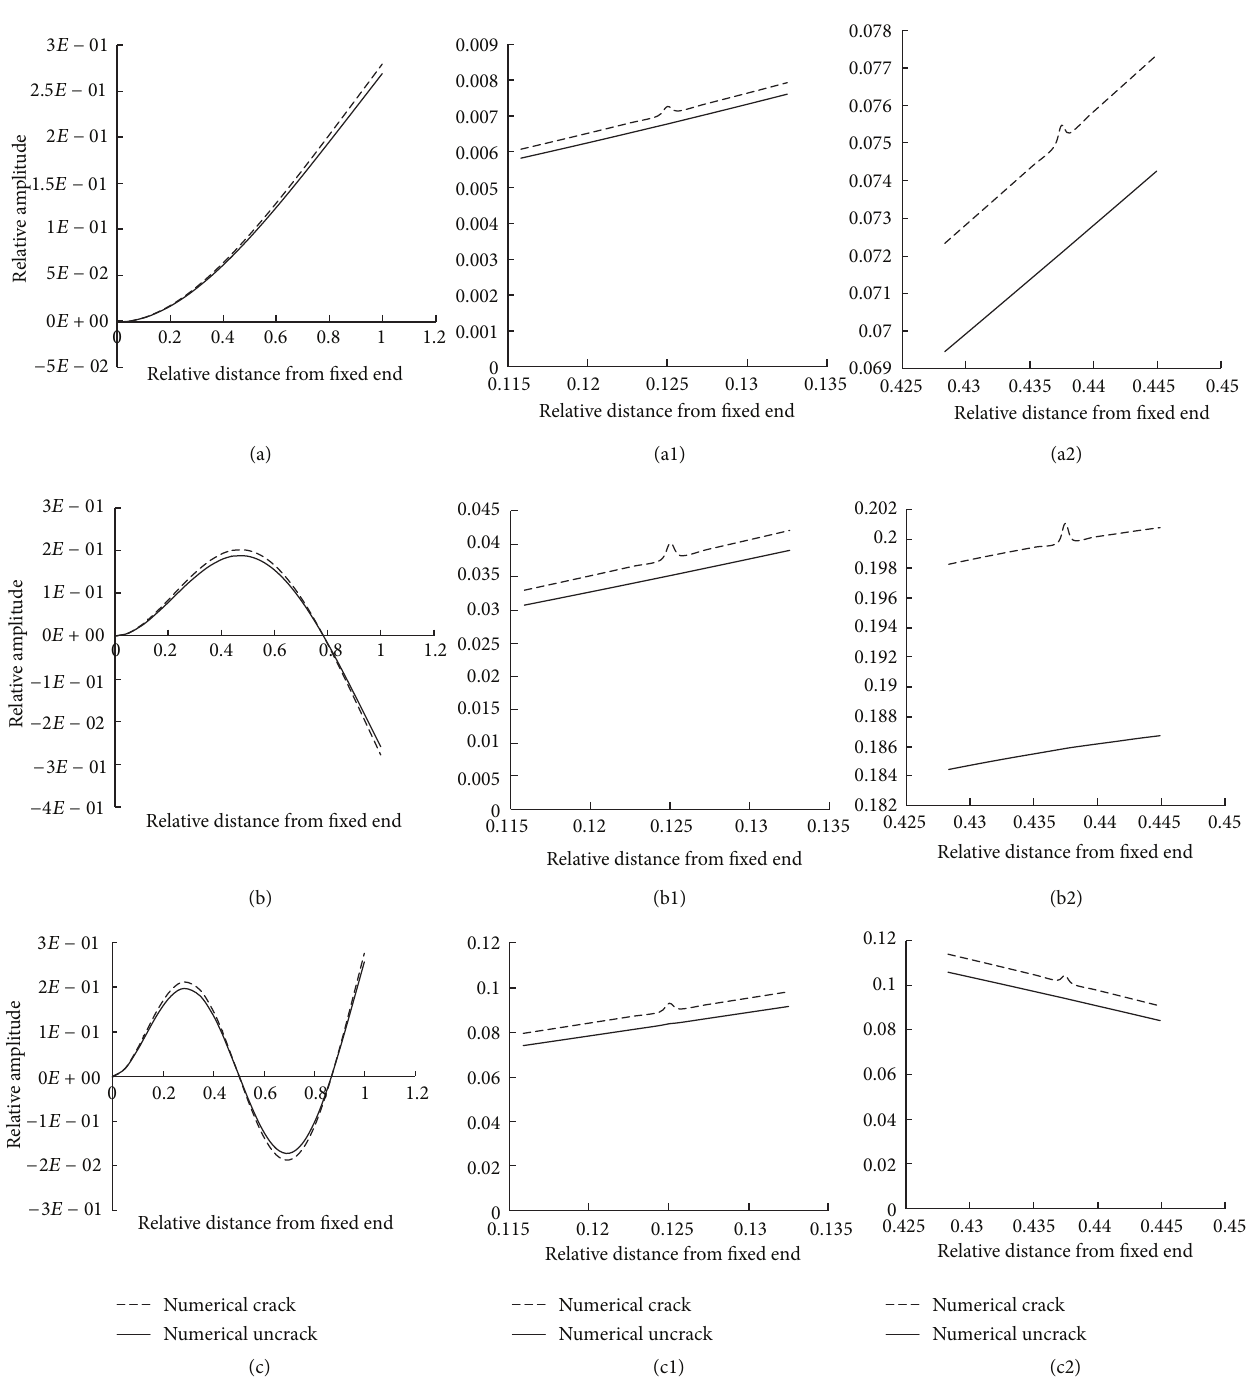
Figure 4: (a) Relative amplitude versus relative distance from the fixed end (1st mode of vibration), 𝑎 1 /𝑊 = 0.0833 , 𝑎 2 /𝑊 = 0.166 , 𝐿 1 /𝐿 = /𝐿 = 0.4375 . (a1) Magnified view of (a) at the vicinity of the crack location 𝐿 0.125 , 𝐿 2 the crack location 𝐿 2 /𝐿 = 0.4375 . (b) Relative amplitude versus relative distance from the fixed end (2nd mode of vibration), 𝑎 1 /𝑊 = 0.0833 , /𝑊 = 0.166 , 𝐿 /𝐿 = 0.125 , 𝐿 /𝐿 = 0.4375 . (b1) Magnified view of (b) at the vicinity of the crack location 𝐿 𝑎 2 1 2 view of (b) at the vicinity of the crack location 𝐿 2 /𝐿 = 0.4375 . (c) Relative amplitude versus relative distance from the fixed end (3rd mode of vibration), 𝑎 1 /𝑊 = 0.0833 , 𝑎 2 /𝑊 = 0.166 , 𝐿 1 /𝐿 = 0.125 , 𝐿 2 /𝐿 = 0.4375 . (c1) Magnified view of (c) at the vicinity of the crack location /𝐿 = 0.125 . (c2) Magnified view of (c) at the vicinity of the crack location 𝐿 𝐿 1